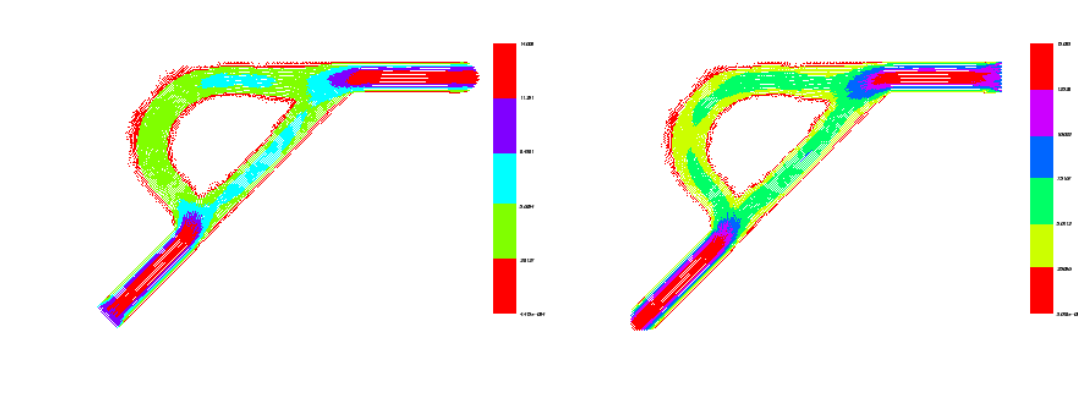
Fig. 6: Forward and backward flow velocity